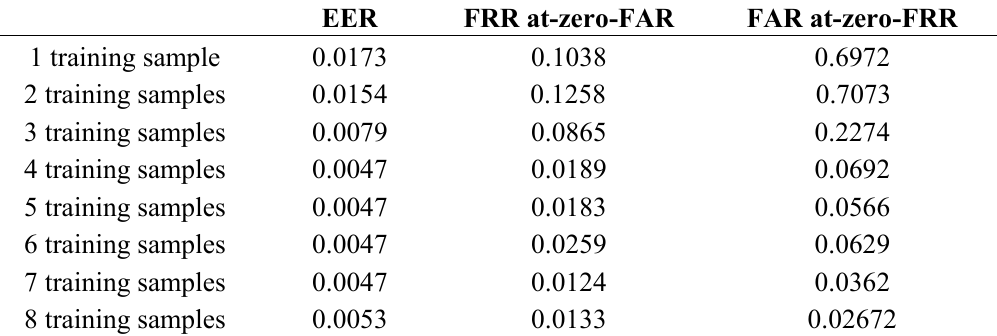
Table 6. Verification of performance with different numbers of training samples.